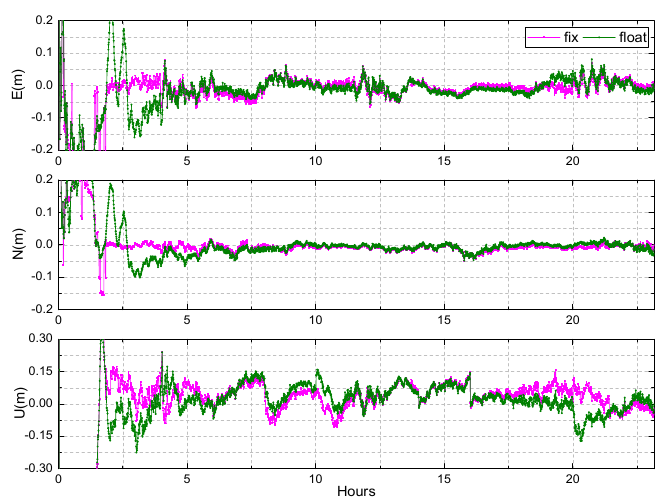
Figure 22. The results of BDS kinematic PPP AR at XMIS, DOY 083 of 2018.